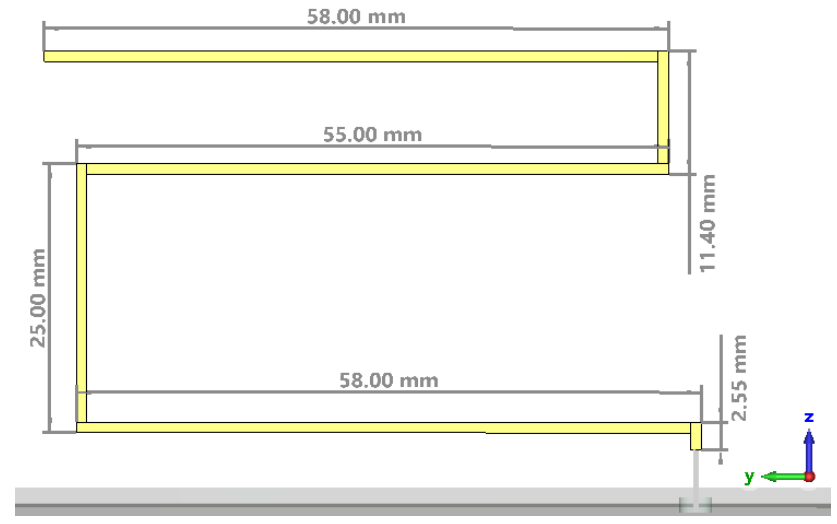
Figure 12. Details of the radiating element for the optimal structure.